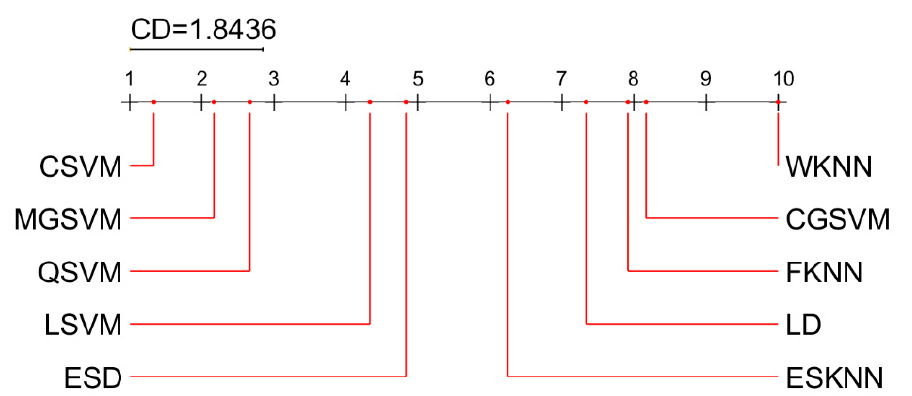
Figure 14. Critical difference diagram from the Nemenyi test: a comparison of classifiers ( α = 0.05).